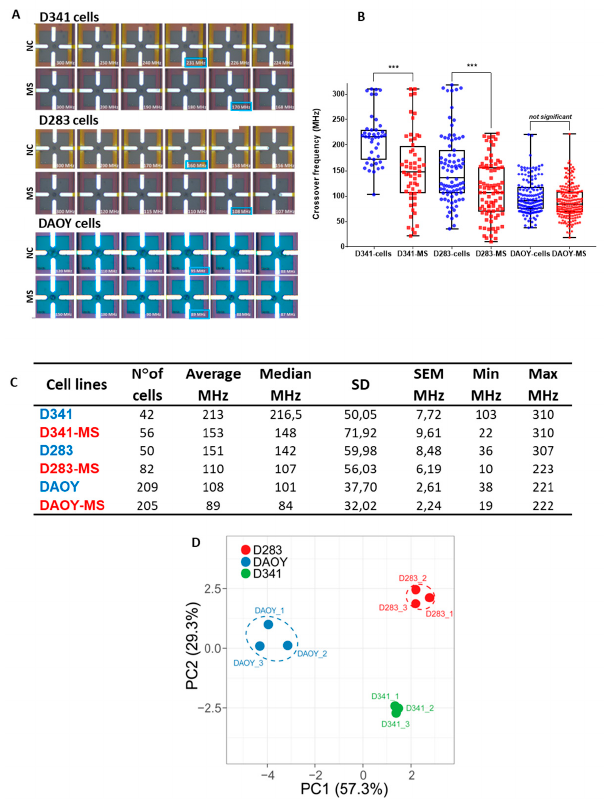
Figure 3. Crossover frequencies of MB cells. Graphic box plots representation of D341 and D283 cells crossover frequencies, cultured in two different conditions: Normal medium (NC) and MS medium ( A , B ). The middle bar represents the median value of the collected data. Summary of the statistic